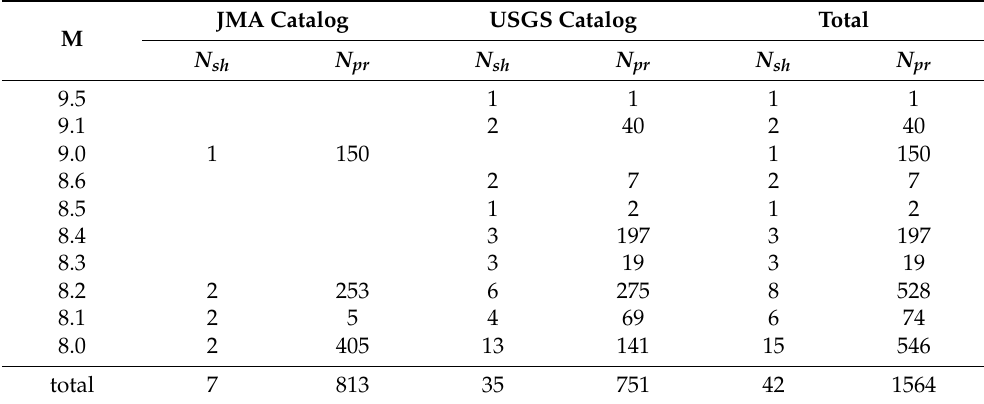
Table 1. Distribution of the number of strong earthquakes used as precedents and their retro-forecasts by magnitude M and